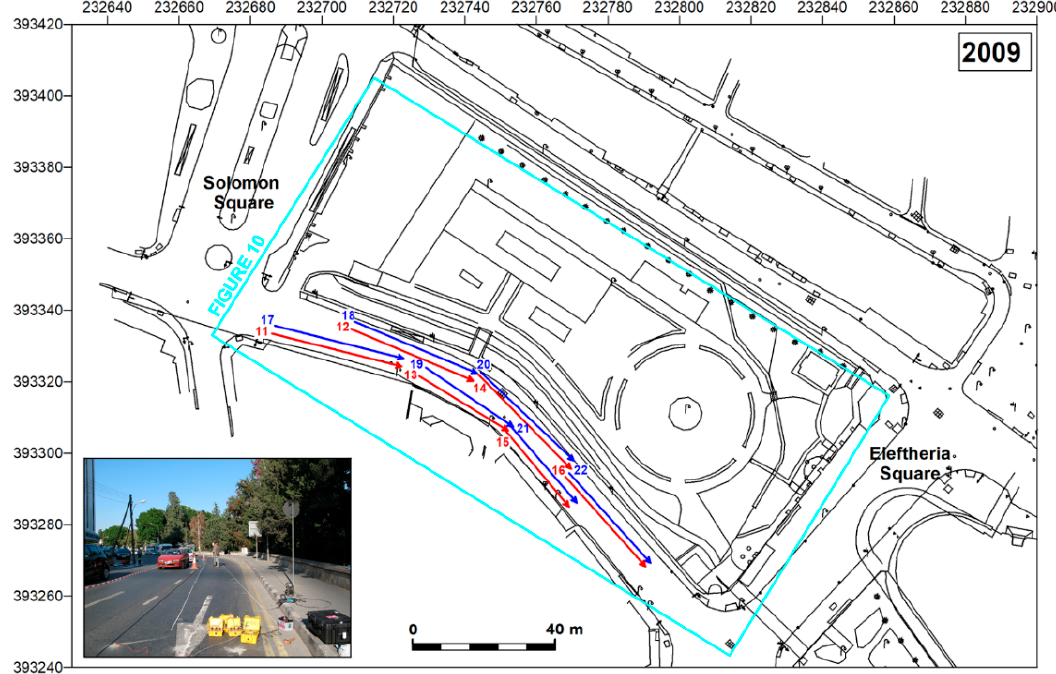
Figure 9. Omirou Avenue: location of ERT profiles 11–22. Blue and red lines indicate the two main fragmented lines of investigation.